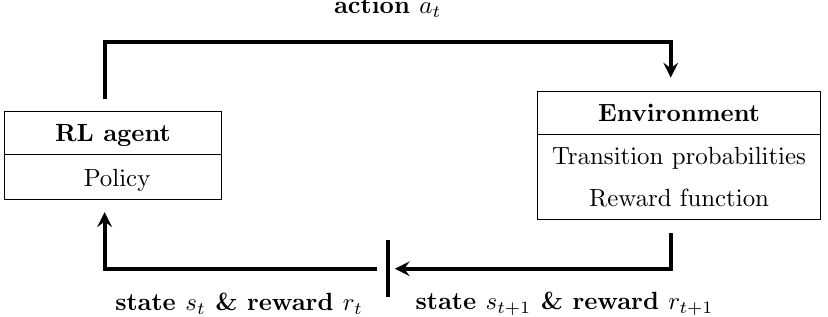
Figure 3. Training loop of the EdgeDewSim environment. The agent receives a job and the state of the devices. It then decides which device to assign the job to and sends that decision back to DewSim.